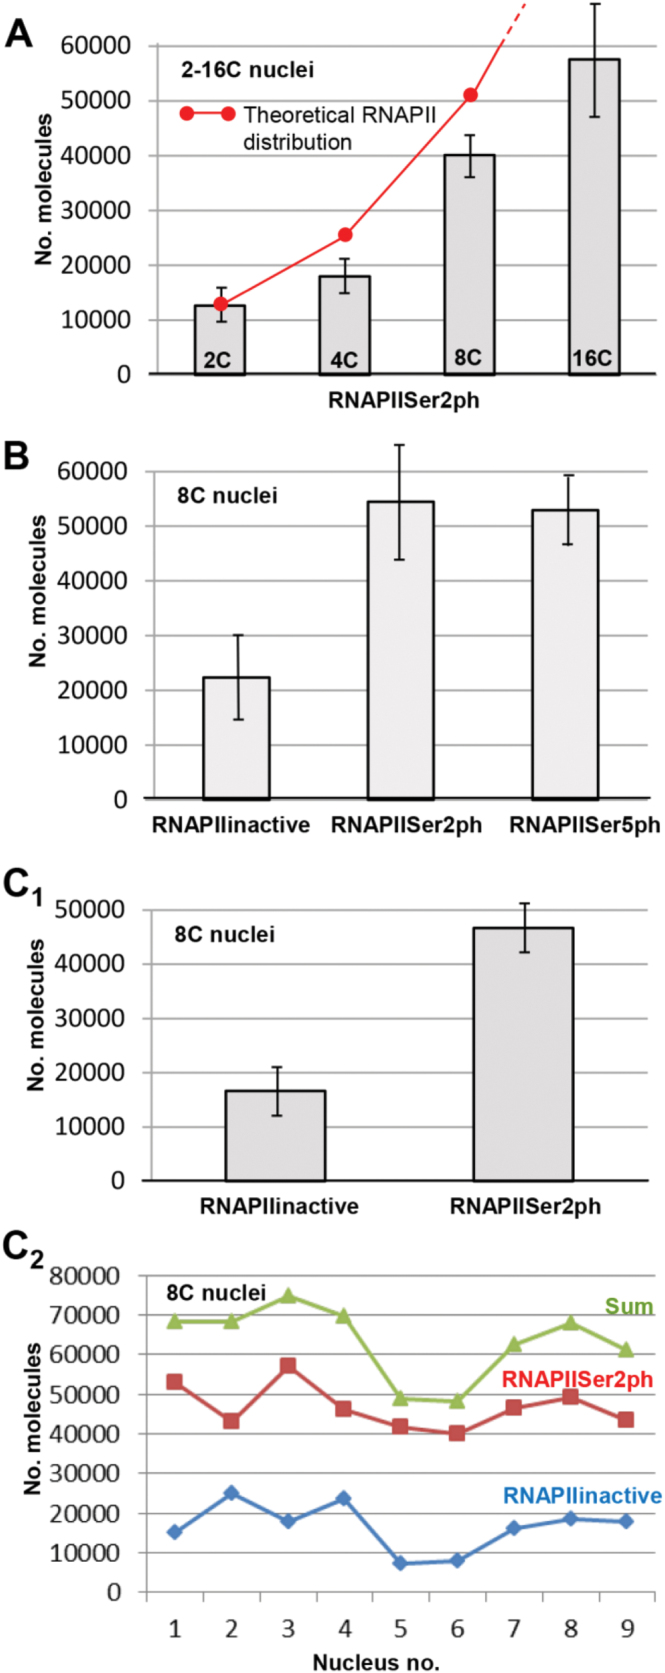
Mean (A, B, C1) and individual (C2) numbers of RNAPII molecules in differentiated A. thaliana leaf nuclei (95% confidence intervals are indicated; for statistics, see Supplementary Table S1 at JXB online). (A) Mean number of RNAPIISer2ph in 2C–16C nuclei. The theoretical RNAPII distribution (red dots) indicates the values expected in the case of exact enzyme duplication during endoreduplication. (B) Mean number of inactive and active (RNAPIISer2ph, RNAPIISer5ph) RNAPII molecules in 8C nuclei. (C1) Mean number of inactive RNAPII and RNAPIISer2ph in simultaneously labelled 8C nuclei. (C2) Numbers of inactive and active (RNAPIISer2ph) RNAPII molecules in nine different nuclei simultaneously labelled with specific antibodies.